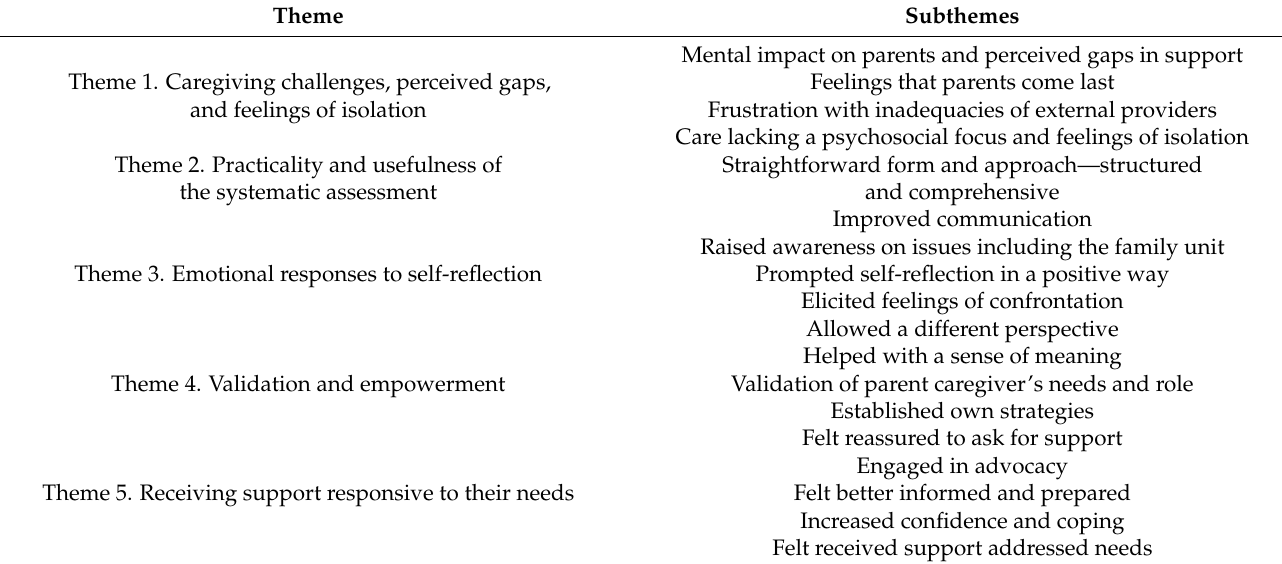
Table 1. Summary of themes and